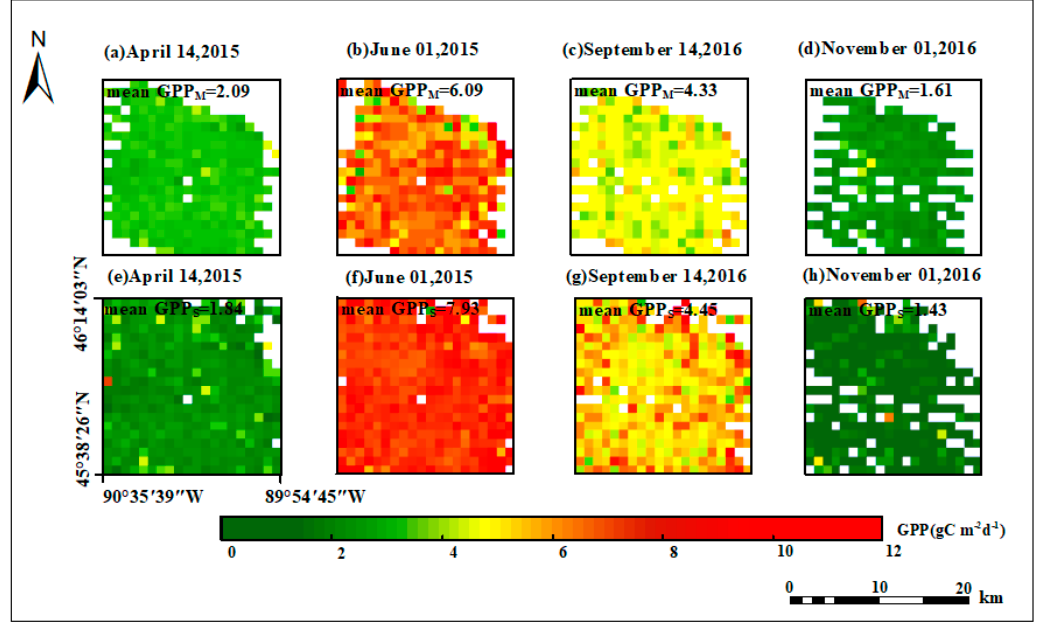
Figure 7. Gridded GPP estimated by means of the SIF-CO 2 -GPP model for four seasons, (a)–(d). Gridded GPP estimated by means of SIF- GPP model for four seasons, ( e )–( h ). The value Gridded GPP estimated by means of SIF- GPP model for four seasons, (e)–(h). The value underneath the date represents the mean modeled GPP data in selected regions and the unit of GPP is g C m − 2 d − 1 .